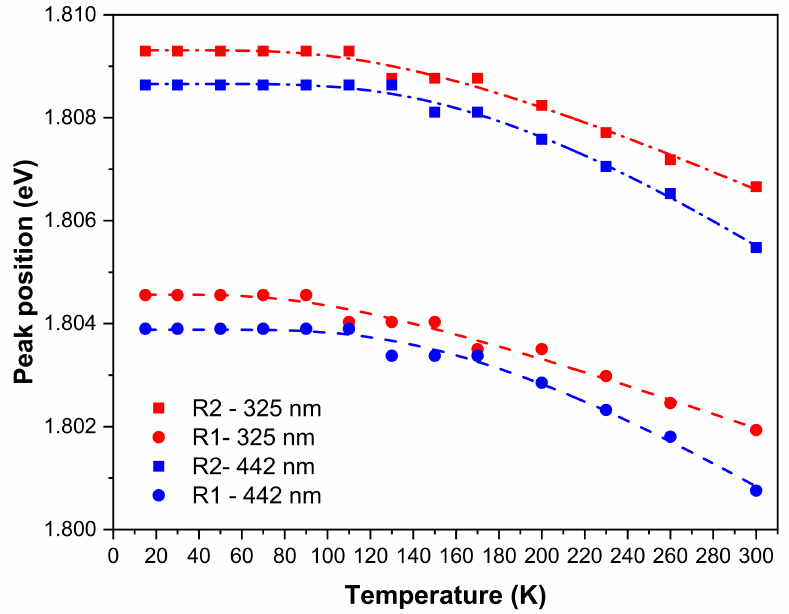
Figure 11. Temperature dependence of the R-lines’ peak position obtained with 325 nm and 442 nm photon excitation, and correspondent fittings according to Equation (3). Table 4. Fit parameters obtained for the R1- and R2-lines’ peak position shift using Equation (3). λ exc